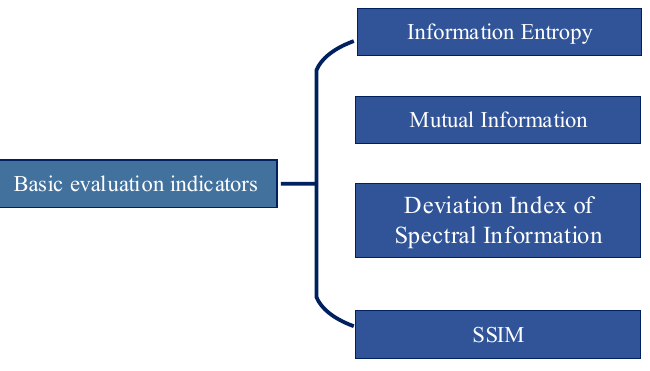
Figure 5. Basic evaluation